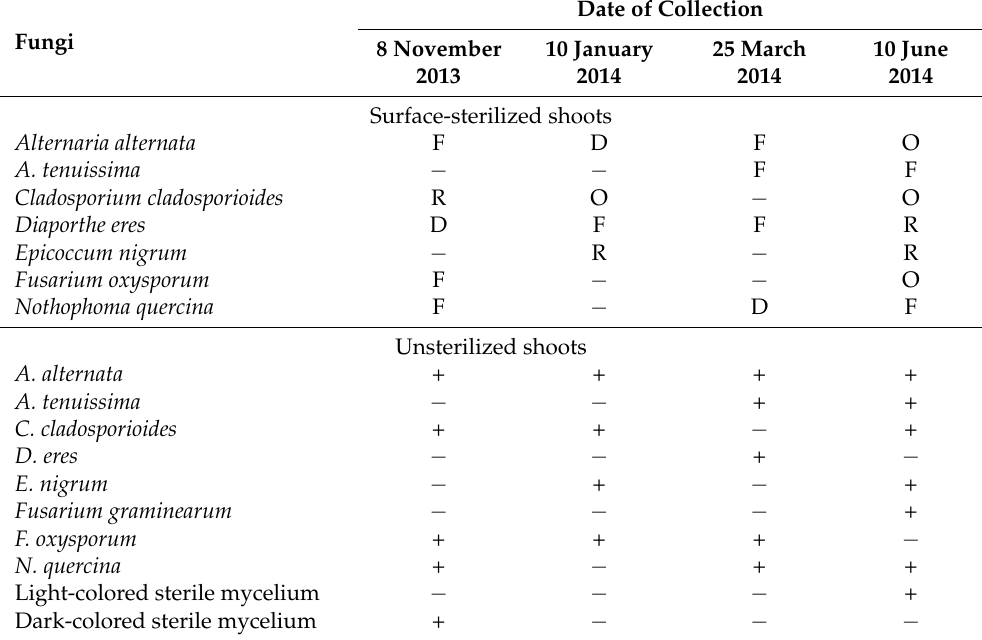
Table 3. Species composition and a frequency of occurrence of fungi isolated from the dormant annual twigs (November–March) and the newly grown shoots (June) of the Manchurian apricot in